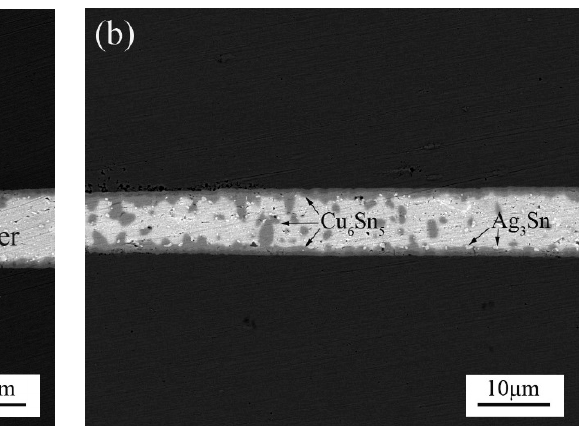
Figure 2. The morphologies of the cross-sectional Cu/SAC305/Cu joints formed at a 400-ms ultrasonic bonding time at different aging times of ( a ) 0 h; ( b ) 120 h; ( c ) 240 h and ( d ) 360 h. The inset in (d): the local enlargement image at the interfaces.